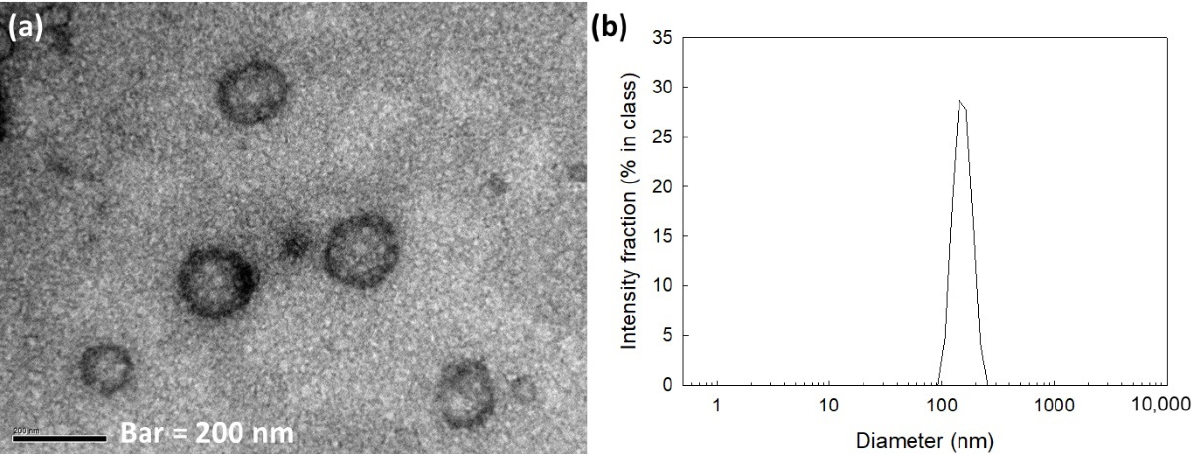
Figure 2. Morphological observations by TEM ( a ) and particle size distribution ( b ) of COSthPBAP nanoparticles (empty nanoparticles, 40/4 in Table 1).